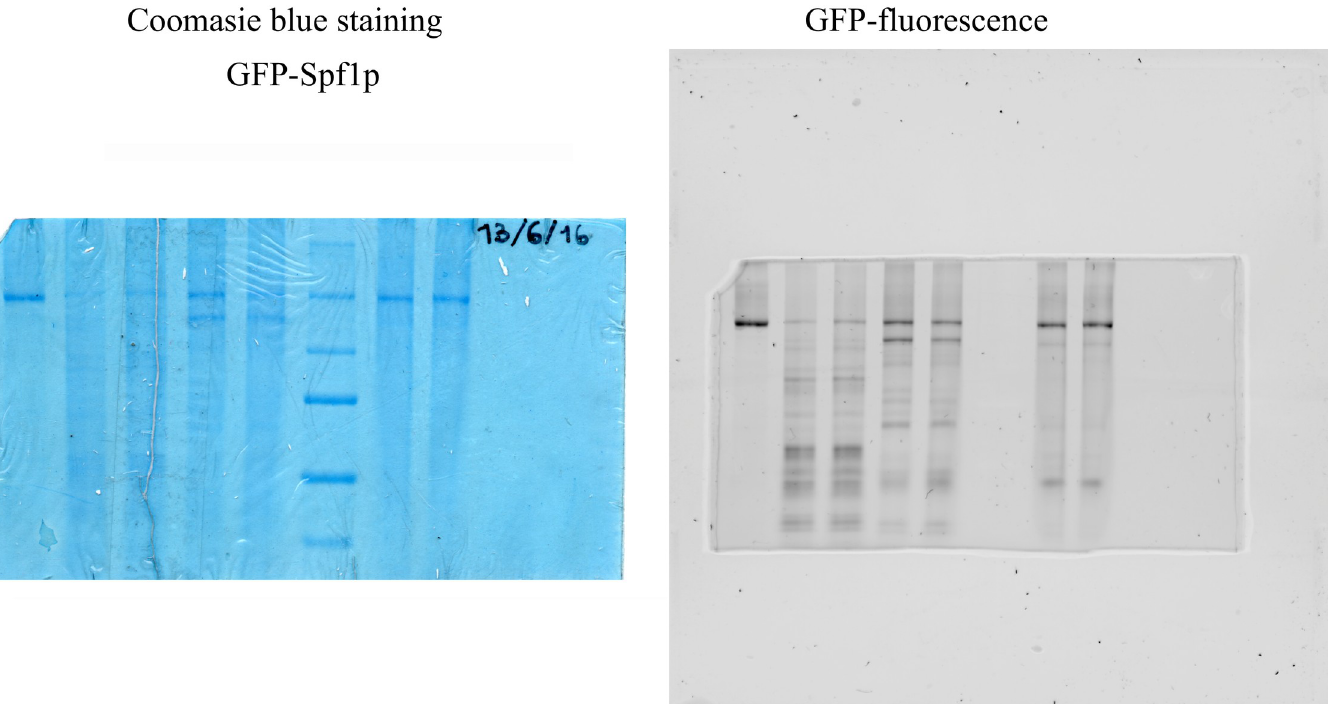
Fig 2. In-gel fluorescence analysis of the GFP-Spf1 digests. 1.5 μ g GFP-Spf1 was exposed for 5 min at 28˚C to the action of the indicated protease as described under “Materials and methods”. GFP-Spf1p: protease ratio (w/w) was Try , trypsin: (5:1), Chy , chymotrypsin (20:1) and Prt K , proteinase K (20:1), and the reaction was stopped by the addition of 12 μ g or 3 μ g of aprotinin for trypsin and chymotrypsin respectively. Proteinase K digestion was stopped by the addition of 0.5 mM PMSF. The panel on the left shows the Coomasie blue stained gel and on the right the measurement of GFP fluorescence. Two lanes from duplicate proteolysis reactions for each protease are